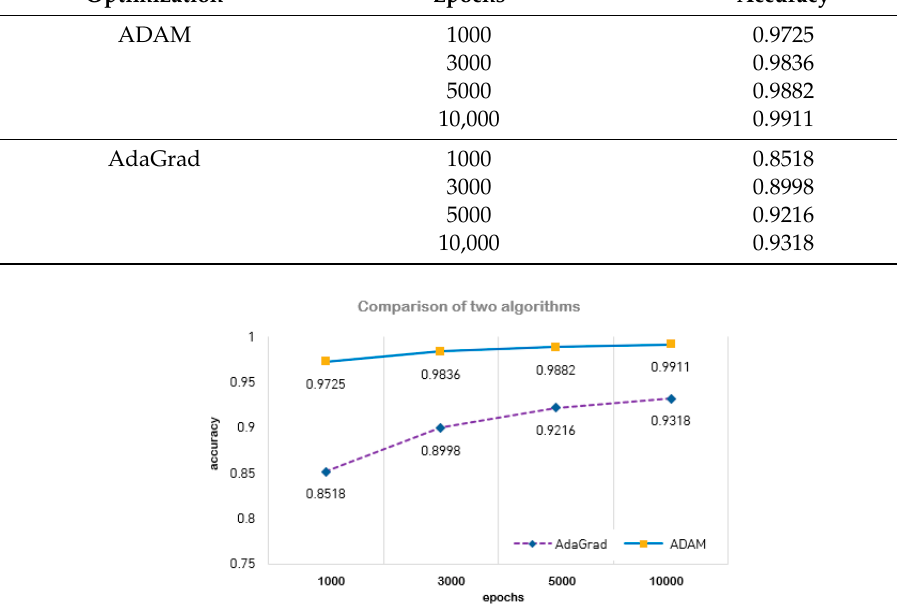
Figure 12. Accuracy comparison of two algorithms: ADAM and AdaGrad.